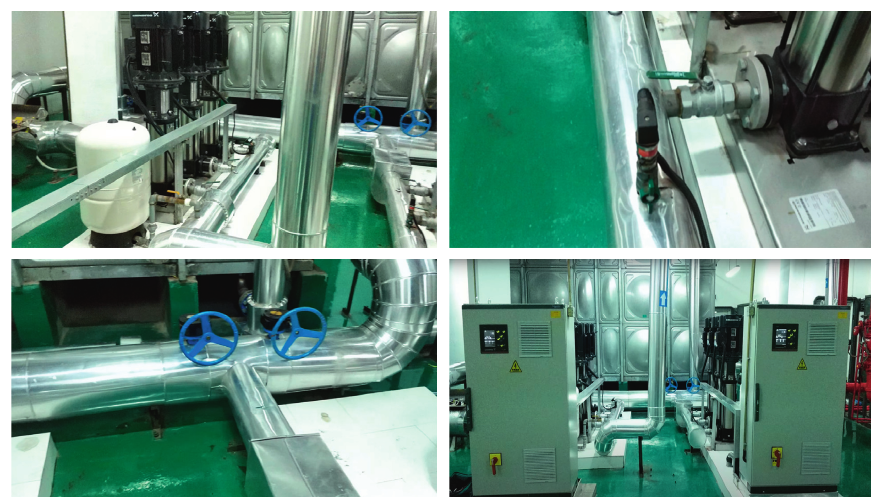
Figure 10: Real scene shooting picture of the emulsion pump station (from Google: